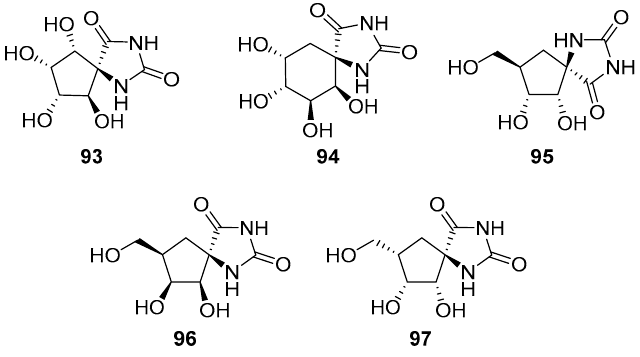
Figure 6. Carbocyclic analogues of hydantocidin.